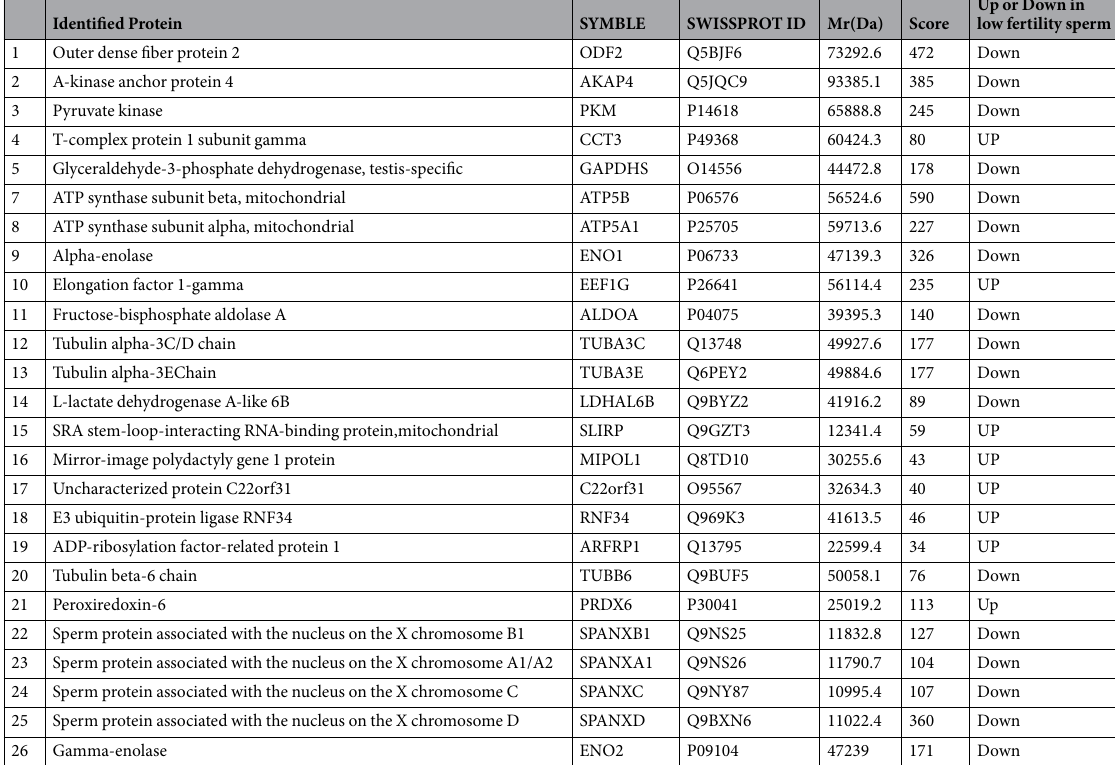
Table 1. The differential proteins identified by